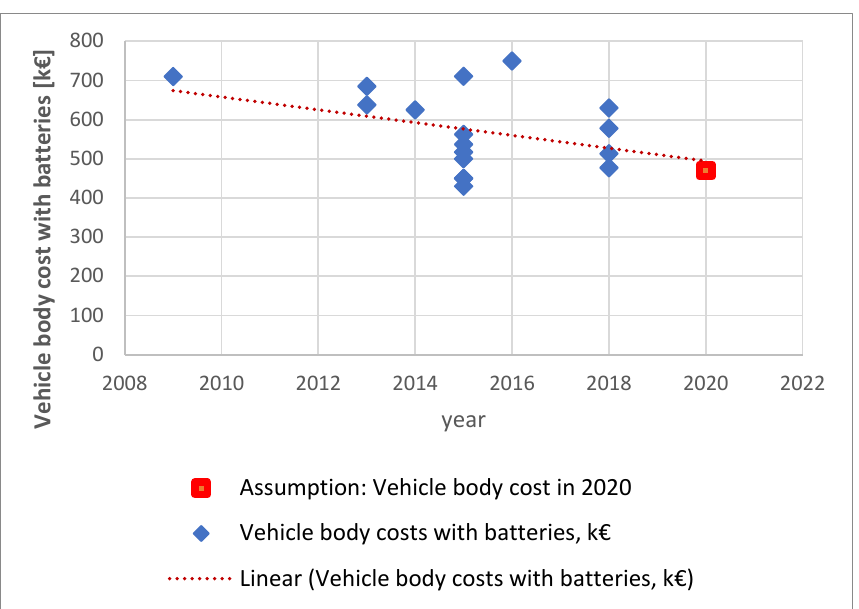
Figure 6. Vehicle body cost including the batteries in the past decade from 2009 to 2018 vs. expected price in 2020